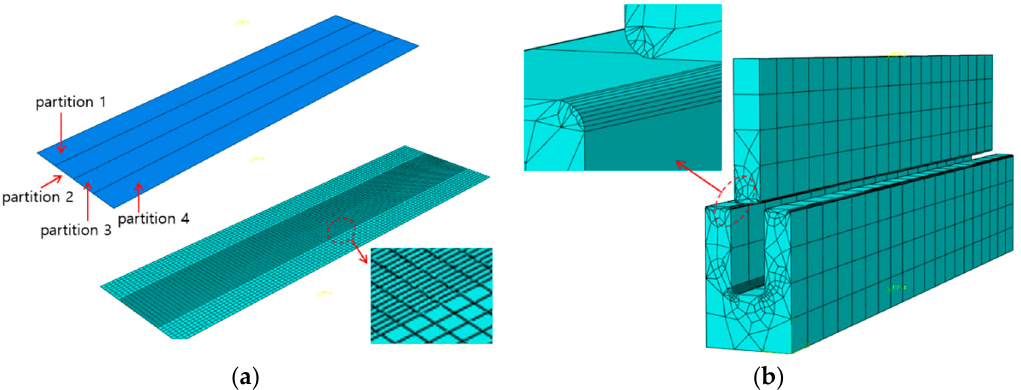
Figure 3. Method of mesh generation for blank and die: ( a ) blank and ( b ) die and punch.